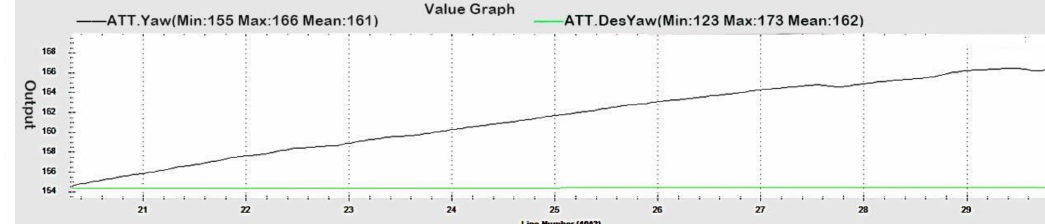
Figure 7. The curve of UAV’s course angle fluctuation under test condition 3. The curve in the graph is the sampling point curve, where the unit of the vertical coordinate is degree. The green line is the expected value of the heading angle, and the red line is the heading angle calculated by the UAV magnetometer, with a fluctuation range of 5.7